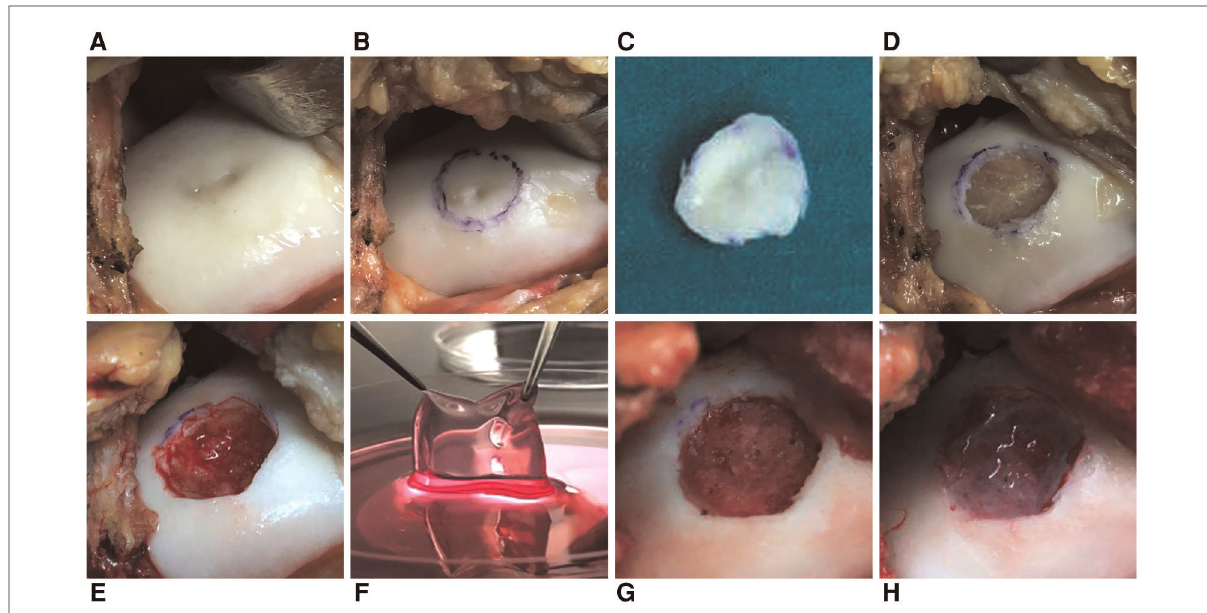
FIGURE 2 Mini-arthrotomy, curettage, and implantation in a patient (female; 36 years; left knee; BMI=19.05 kg/m 2 ; other surgery: bone grafting). ( A ) The cartilage defect was exposed. ( B,C ) The unhealthy cartilage was marked and removed. ( D ) The subchondral bone was exposed, and cystic degeneration could be seen. ( E ) The cystic degeneration in subchondral bone was removed, and blood effusion could be observed. ( F ) The patch was placed in 0.9% saline <5 min before transplantation. ( G ) A contralateral autogenous posterior iliac bone graft was made. ( H ) The patch was placed into the defect. Fibrin glue was applied to the surface to fi x the patch to the defect without